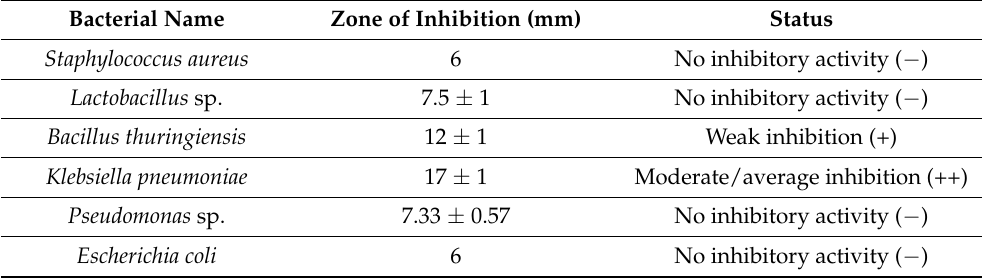
Table 1. Antagonistic activity of the six selected strains against Aeromonas sp.